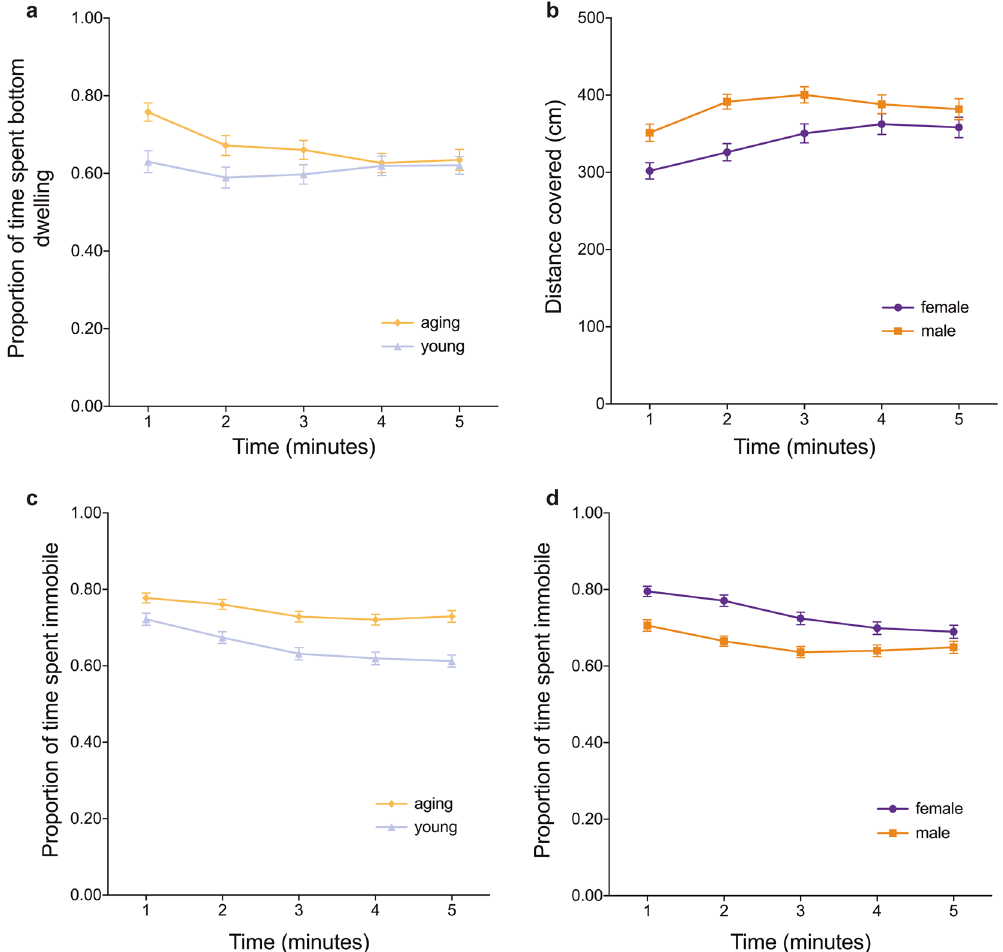
Figure 2. Results of the novel tank diving test. ( a ) Overall proportion of time spent in the bottom third of the tank over the duration of the test. ( b ) Distance covered by males and females for each minute of the novel tank test. ( c ) Proportion of time aging and young, and ( d ) males and females spent in an immobile state over the 5 min of the test. All error bars represent ± standard error mean